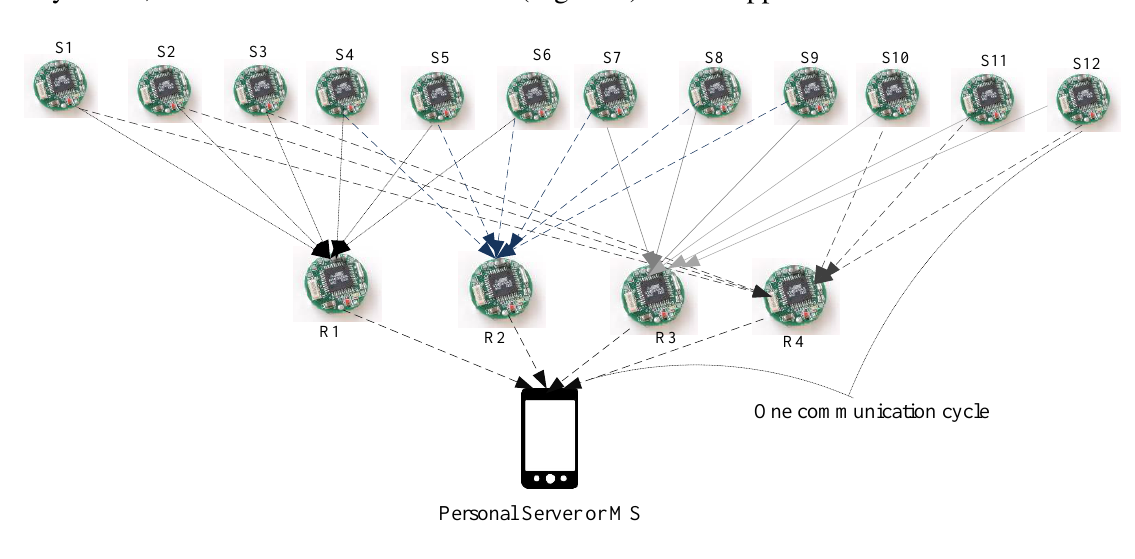
Figure 3. The network scenario